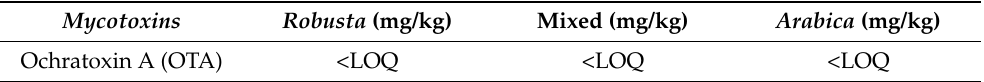
Table 4. Concentrations (mg/kg) of mycotoxins in three classes of samples ( n = 10) of coffee silverskin (CS).